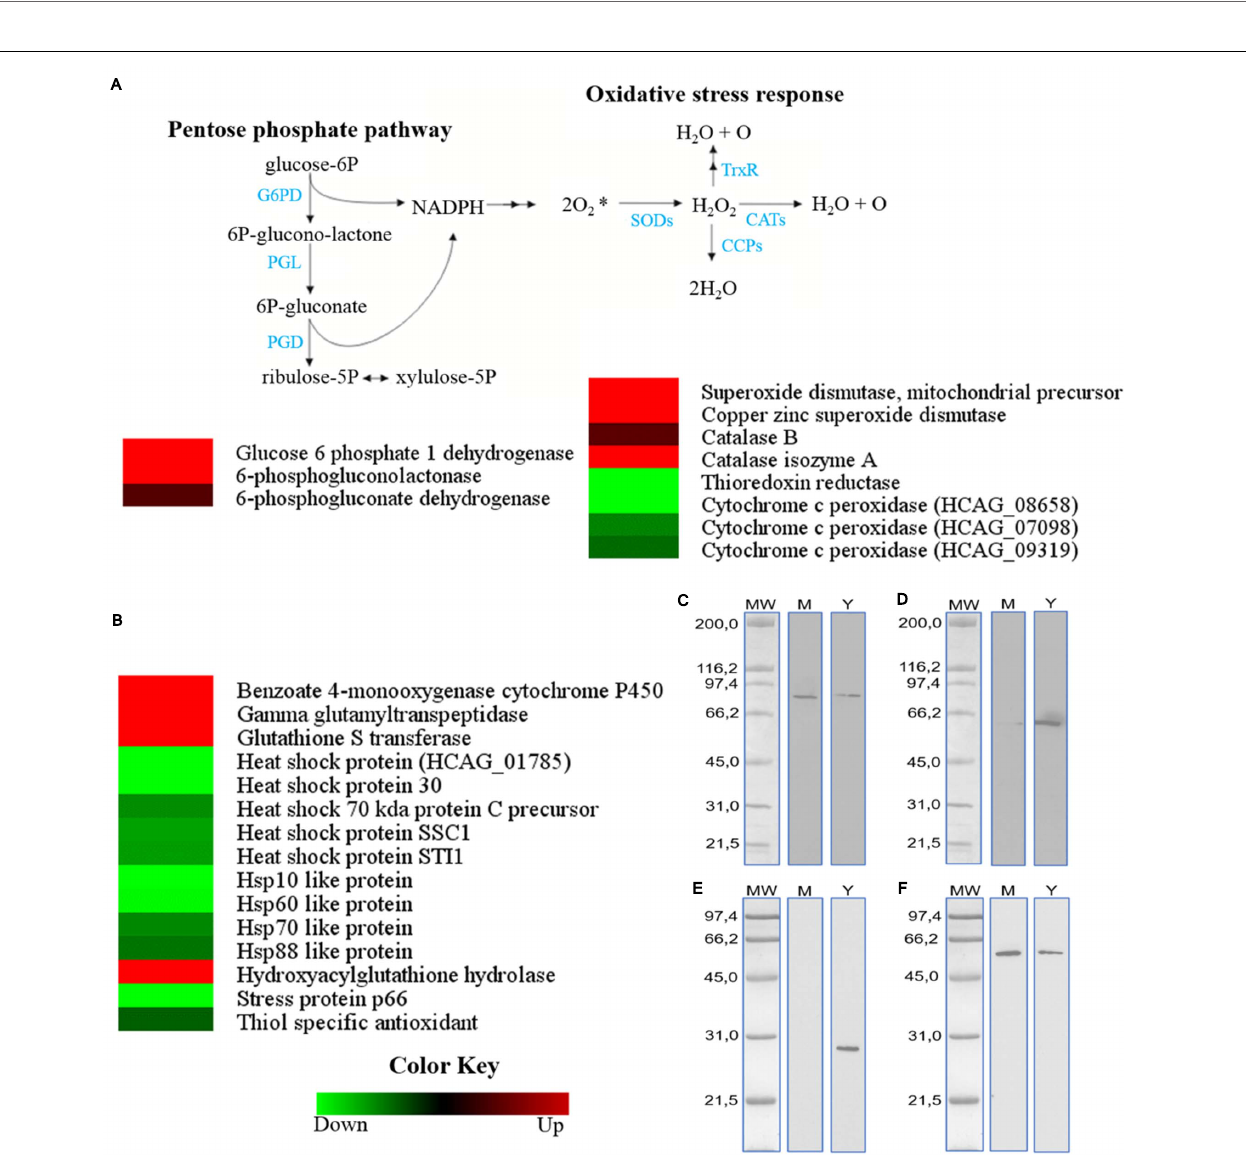
FIGURE 3 | Comparison of protein profiles related to pentose phosphate pathway and stress response in H. capsulatum mycelium and yeast forms. Dataset comparisons were carried out as cited in the Figure 2 legend. (A) The diagram representing the pentose phosphate and oxidative stress response pathways represents differentially abundant proteins in the mycelium and yeast phases. (B) Comparison of protein profiles related to the stress response in mycelium and yeast forms of H. capsulatum . Changes in the abundance levels in the mycelium compared with the yeast are represented in the heat map. Experimental triplicate mean values are presented for the lowest (green) and the highest (red) abundance of H. capsulatum proteins in the mycelium form. Black indicates that no significant difference was observed. G6PD, glucose 6 phosphate 1 dehydrogenase; PGL, 6-phosphogluconolactonase; PGD, 6-phosphogluconate dehydrogenase; SODs, superoxide dismutases; TRxR, thioredoxin reductase; CATs, catalases; C, cytochrome c peroxidases. Confirmatory Western blot analysis of selected proteins detected in the H. capsulatum proteomic analyses. Protein extracts are shown after the reaction with antibodies against the following proteins: (C) catalase; (D) HSP60; (E) HSP30; (F) β -tubulin, as a loading control. The blots were incubated with goat anti-mouse IgG polyclonal or goat anti-rabbit IgG polyclonal antibodies coupled to peroxidase and developed with SuperSignal West Dura Chemiluminescent substrate (Pierce, Rockford, IL, United States). The X-ray films